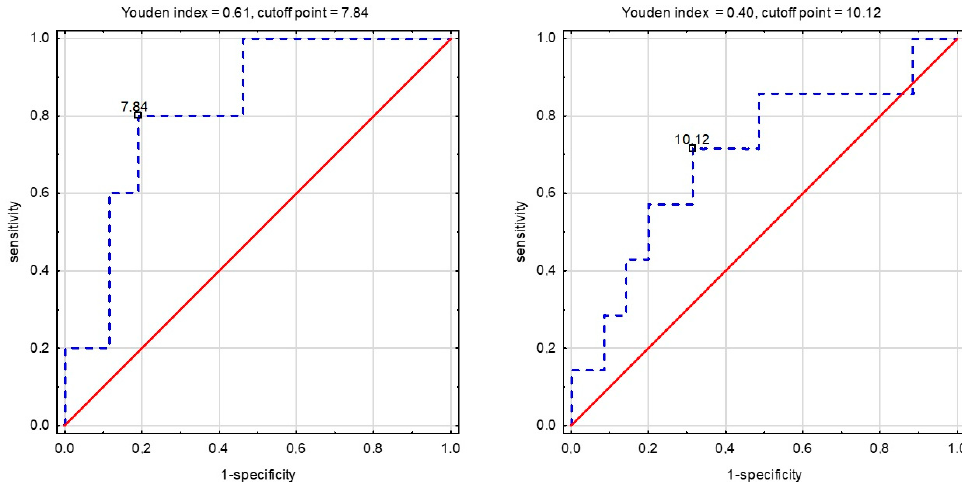
Figure 2. The receiver operating characteristic curve for skeletal muscle index predicts positive changes in SBP in experimental group (EG) males and experimental group (EG) females.